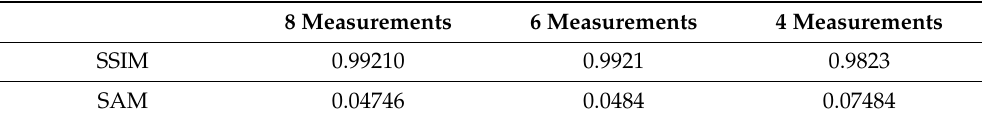
Figure 10. Figure shows 6 representative spectra reconstruction from the dataset of Pavia University. Each spectrum is reconstructed from 3 different SpLMs (8 measurements, 6 measurements, and 4 measurements). The spectra have 103 spectral bands in the range of ( 430 nm–850 nm ) . Table 3. The mean SSIM and mean SAM over the dataset of Pavia University for 3 configurations (8 measurements, 6 measurements, and 4 measurements).